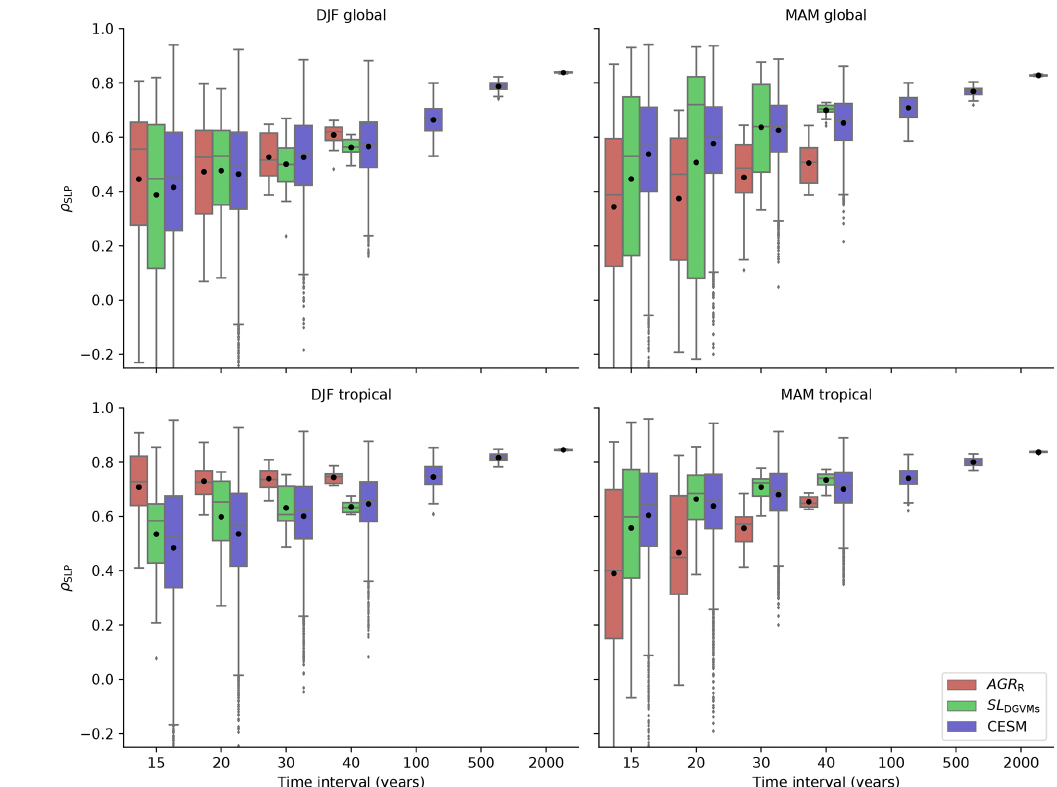
Figure 6. Predictability of AGR R , SL DGVMs , and CESM NBP under various time intervals. The predictability of AGR R and SL DGVMs is within the period 1959–2017, with a 1-year step sliding window of 15, 20, 30, and 40 years. The predictability of CESM is in the period 1000– 5000 and covers extra intervals of 100, 500, and 2000 years. The distribution of the predictability under each sliding window with SLP in DJF global, MAM global, DJF tropical, and MAM tropical is shown. Tropical domains are 18 ◦ N–18 ◦ S for SLP as predictors in predicting AGR R and SL DGVMs , as well as 20 ◦ N–20 ◦ S for SLP as predictors in predicting CESM. Note that the mean values are shown as black